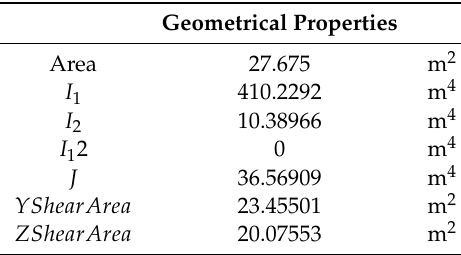
Figure 5. Schematic sketch of reducing procedure. Table 1. Base Wing Beam Characteristics.